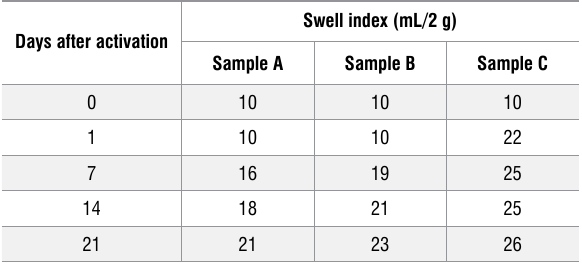
Swell index of the three samples tested over time after